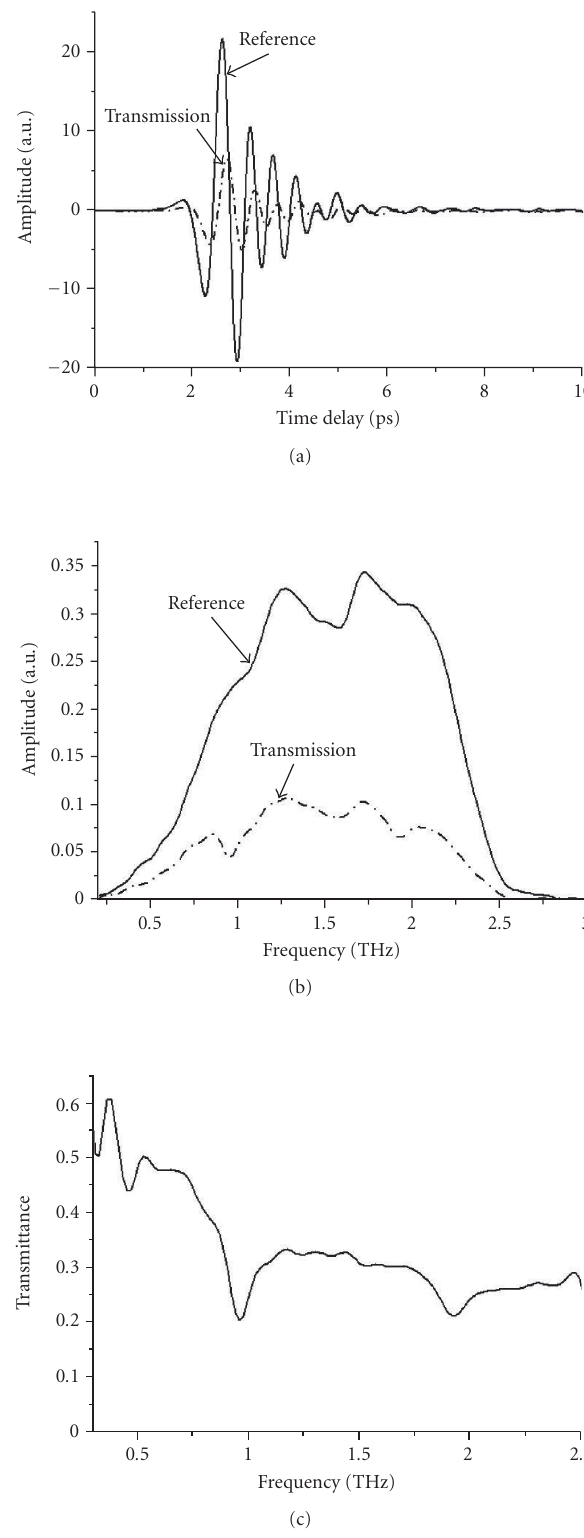
Figure 2: Nonresonant terahertz transmission properties of the grating exposed to p -polarized incident wave with grating period p = 320 ± 15 μ m, slit width w = 70 ± 5 μ m, and grating depth h = 3mm. (a) Time domain traces of terahertz pulses. (b) Corre- sponding Fourier spectra. (c)